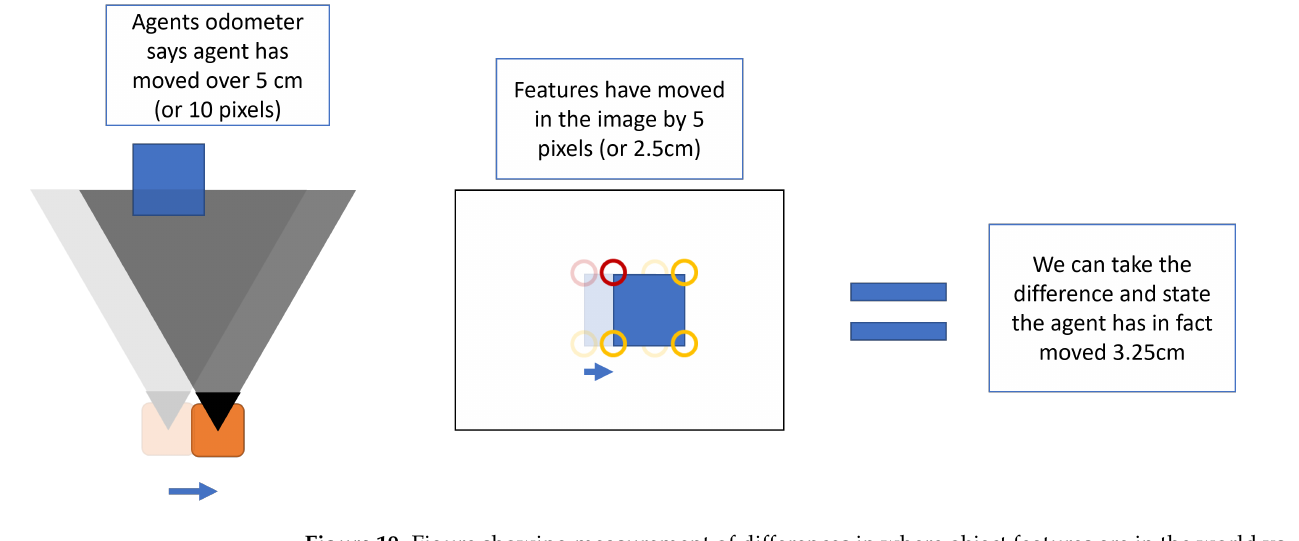
Figure 19. Figure showing measurement of differences in where object features are in the world vs. the prediction based on the agent’s